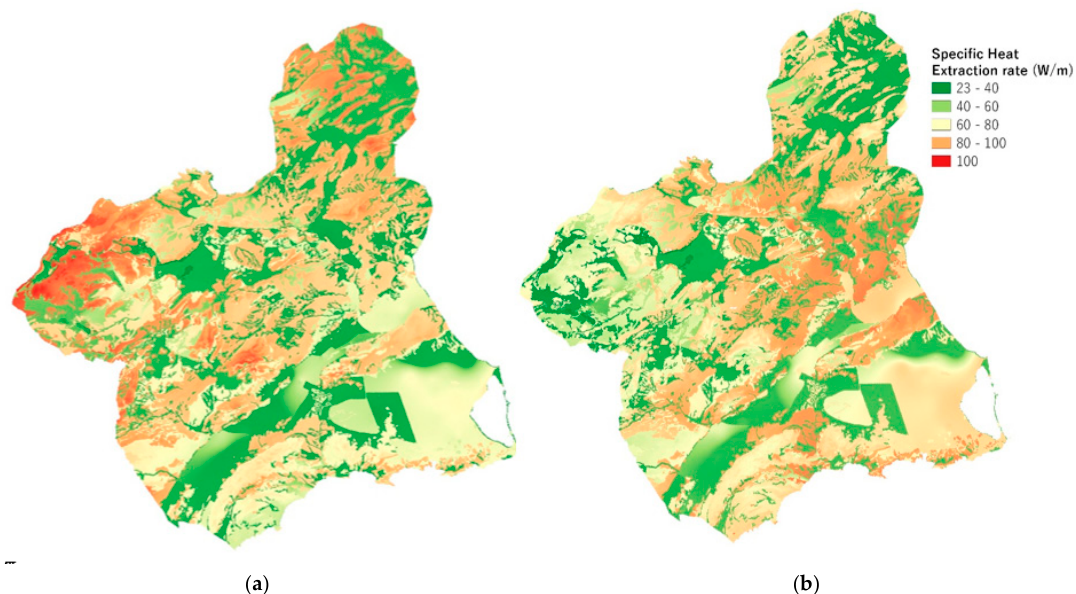
Figure 8. Specific heat extraction (sHE) rate for cooling mode ( a ) and heating mode ( b ) estimated with G. POT method based on the hydrogeological and climatic conditions.